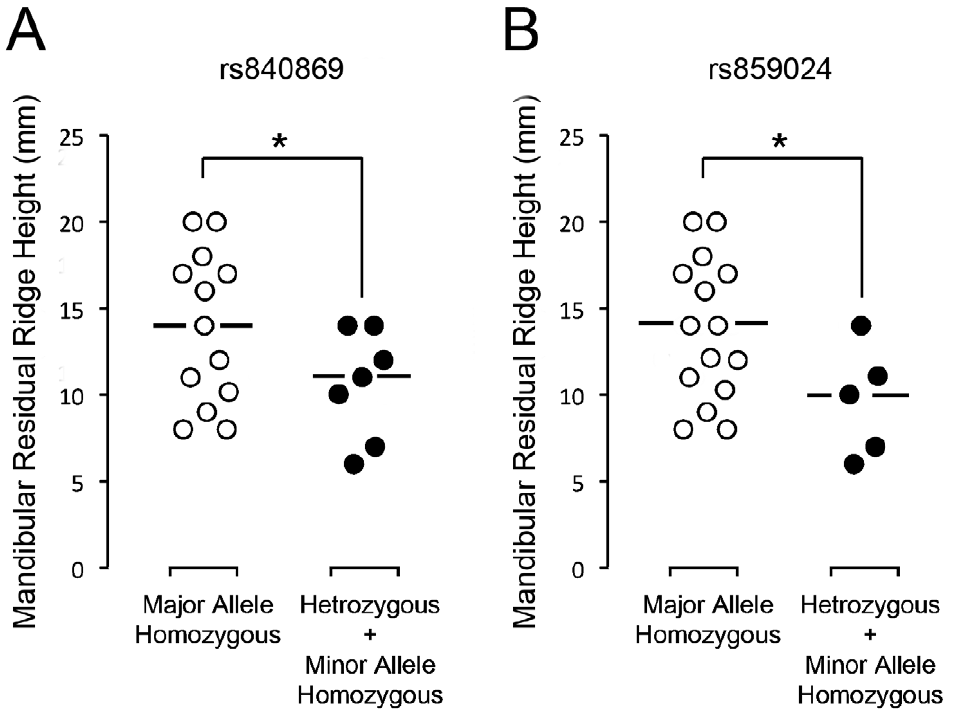
Figure 4. FGFR1OP2/wit3.0 SNPs rs840869 (A) and rs859024 (B) genotypes and mandibular edentulous ridge height. Subjects with the major allele homozygous of SNPs rs840869 and rs859024 (white circles) were found in Type II (n=6) and Types III/IV (n=6) groups with the median mandibular residual ridge height of 15.0 mm and the average height of 14.2 6 4.5 mm. Subjects with heterozygous or minor allele homozygous of rs840869 and rs859024 (black circles) were found only in Types III/IV group with median mandibular edentulous ridge height of 11 mm and 10 mm, respectively, and the average height of 10.6 6 3.2 mm and 9.6 6 3.2 mm, respectively. * P , 0.05.